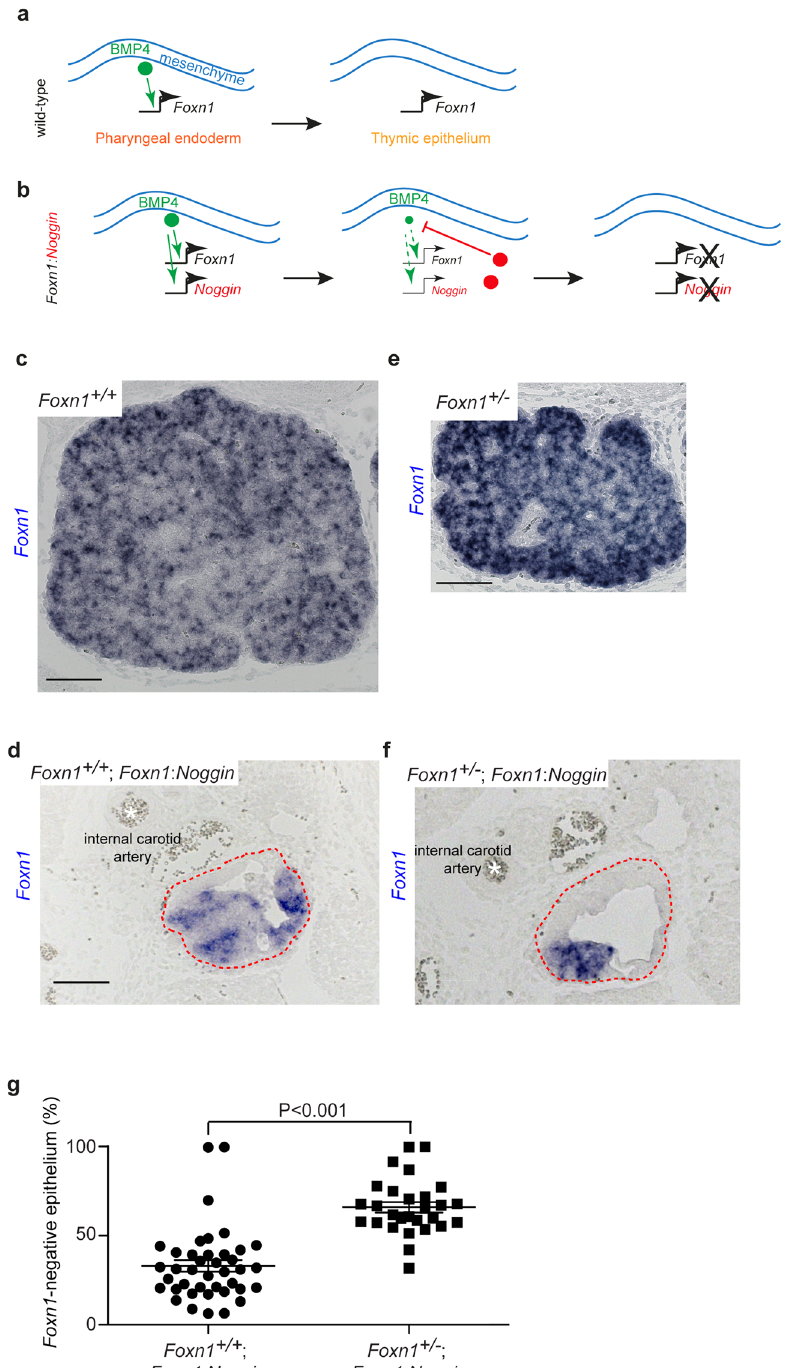
Figure 1. Role of BMP signalling and Foxn1 dosage in thymus development. ( a ) Schematic of the developmental sequence giving rise to the initiation of Foxn1 expression in the future thymic epithelium (for details, see text). ( b ) Schematic illustrating the time-delayed feedback inhibition system enabled by the transgenic expression of the BMP inhibitor NOGGIN under the transcriptional control of the Foxn1 gene promoter (for details, see text). Panels (c) to (f) depict results of RNA in situ hybridization using a Foxn1 - specific probe (positive cells stained blue). ( c ) At day 15.5 of embryonic development (E15.5), the thymic epithelium of wild-type ( Foxn1 + / + ) mice uniformly expresses Foxn1 . ( d ) Generation of Foxn1 -negative thymic epithelia through time-delayed feedback inhibition in the thymic anlage (encircled with dotted red lines) at E15.5, as revealed by RNA in situ hybridization in Foxn1 + / + ; Foxn1:Noggin mice. ( e ) At E15.5, the thymic epithelium of Foxn1 -heterozygous ( Foxn1 + / − ) mice uniformly expresses Foxn1 , although the rudiment tends to be smaller 16–20 than in Foxn1 + / + siblings (see Fig. 2). ( f ) In E15.5 Foxn1 + / − ; Foxn1:Noggin transgenics, the Foxn1 -negative domain is larger than in Foxn1 + / + ; Foxn1:Noggin transgenics. For orientation, the position